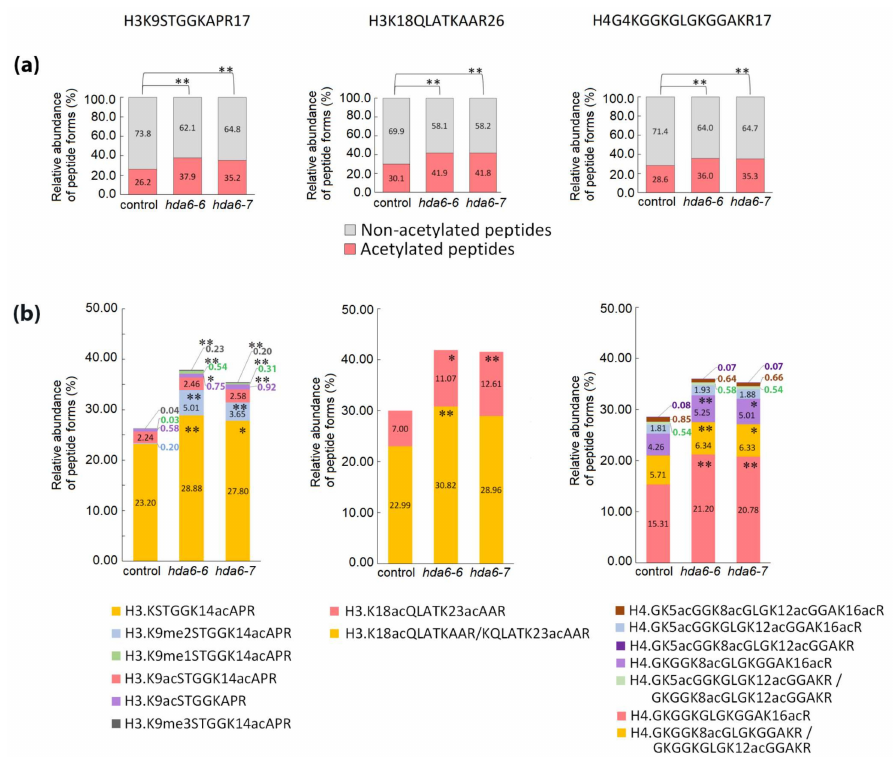
Figure 3. Relative abundance of peptide forms of histones H3 and H4 in leaves of wild type Arabidopsis plant (control) and hda6 mutant lines ( hda6-6 , hda6-7 ). ( a ) The relative abundance of all peptide forms containing acetyl group(s) compared with that of peptides without acetylation. ( b ) The relative abundance of particular peptide forms containing acetyl group(s) compared with that of all other forms of respective peptide sequences. The levels of peptide forms were determined from the extracted ion chromatograms (XIC) peak areas. The significance of between-sample di ff erences was assessed using t-tests, setting the significance threshold at ** p < 0.01 and * p <